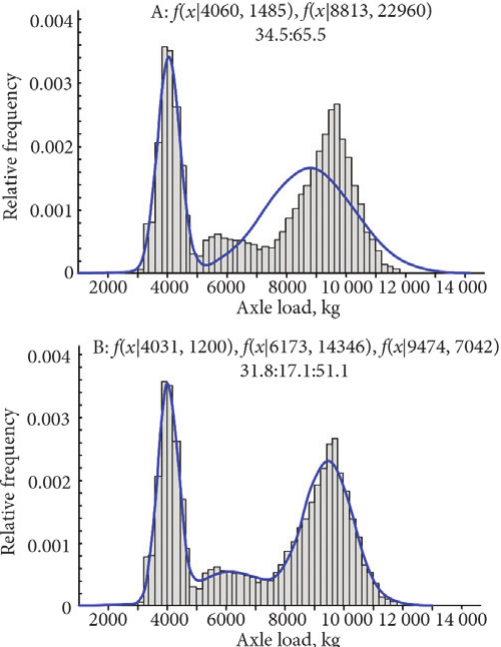
Fig. 3. Best fit of multiple Gaussian distribution mixtures: a – mixture of 2 distributions; b – mixture of 3